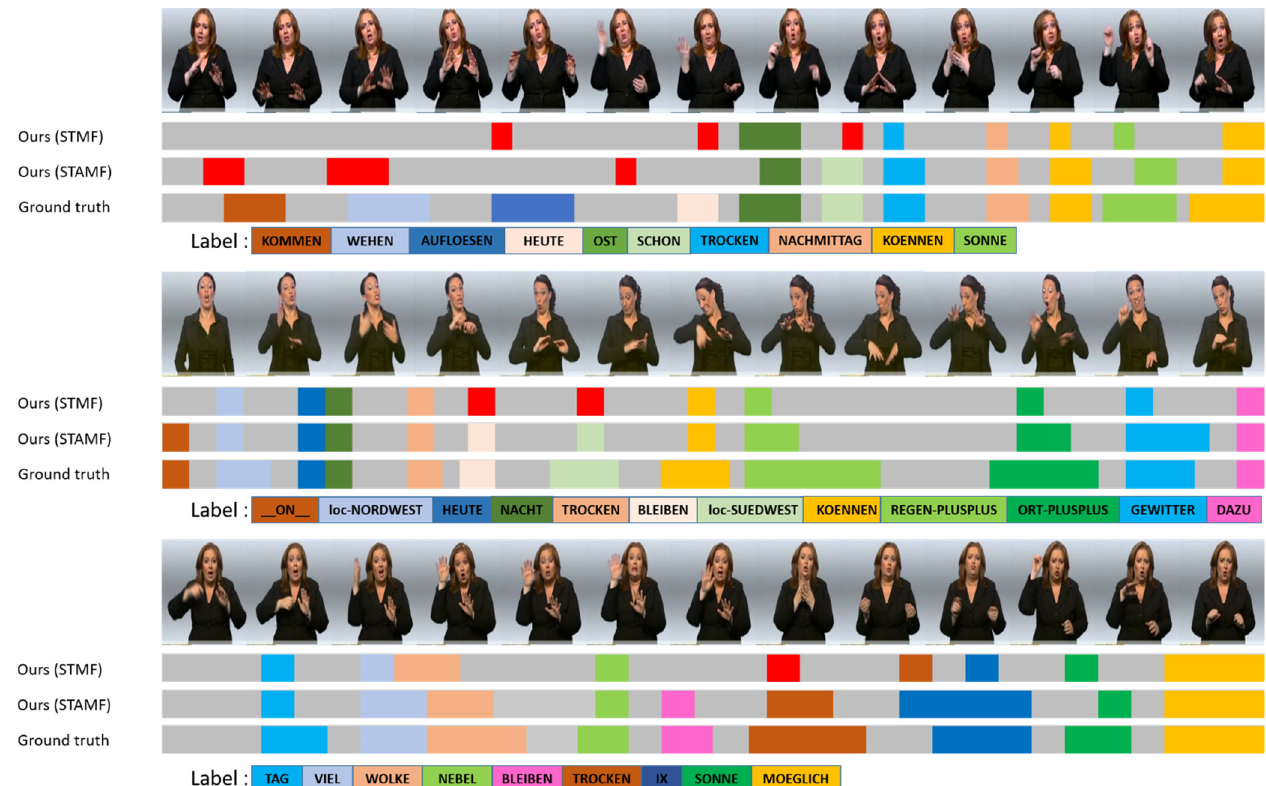
Figure 8. Qualitative evaluation of the recognition result using a different configuration of the RWTH-PHOENIX dataset [33,39]. The wrong predicted glosses are marked in red.